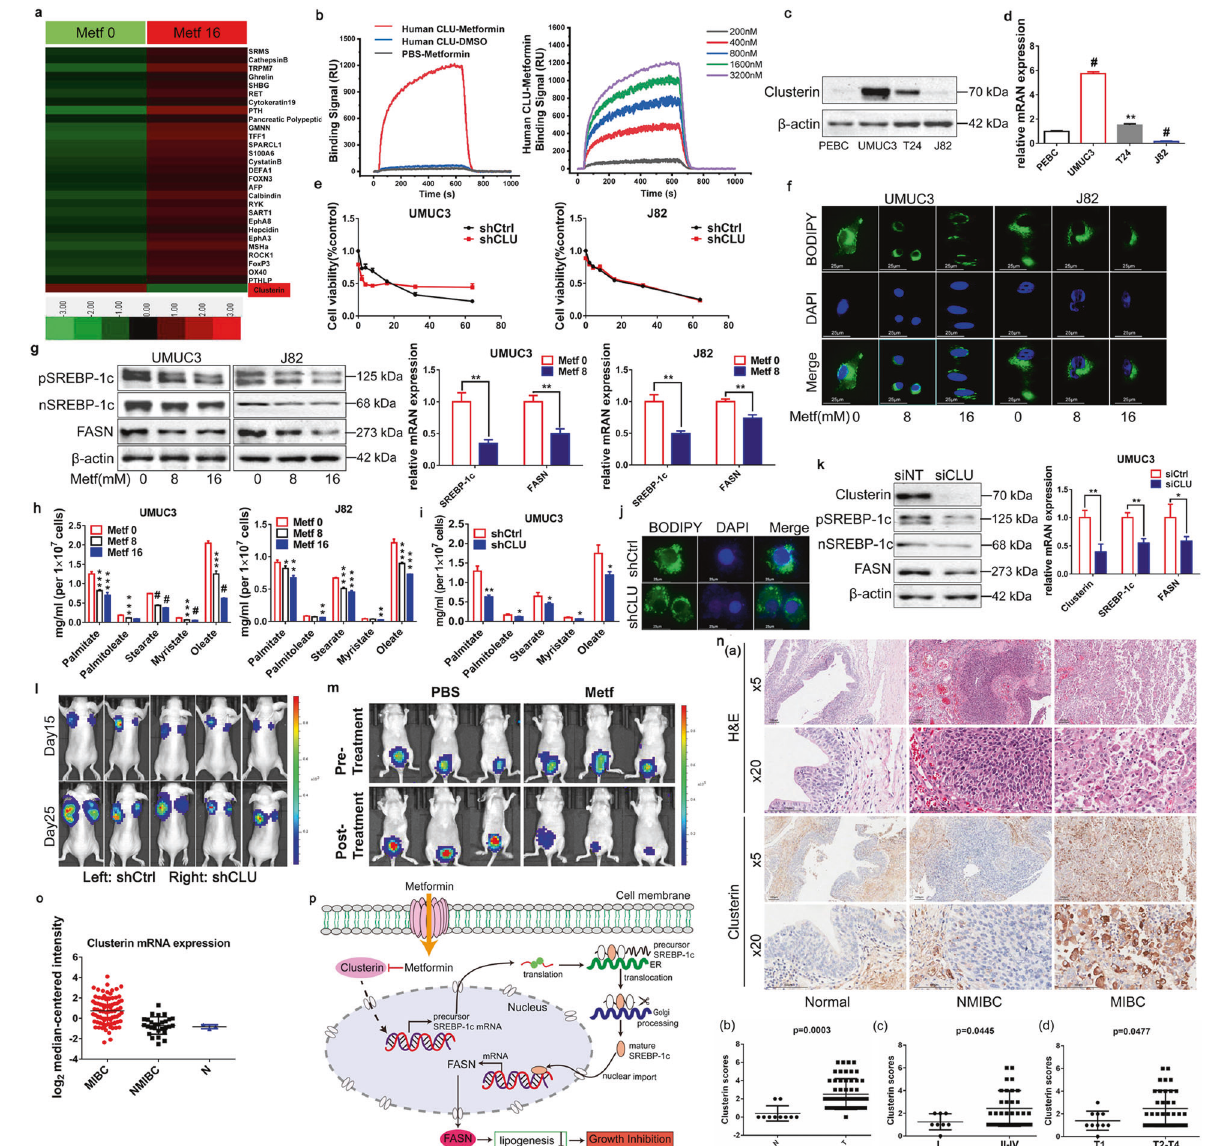
Fig. 1 a High-throughput protein chip was used to screen differential proteins with metformin treatment in T24 cells for 48 h. Metf 0 metformin 0 mM, Metf 16 metformin 16 mM. b SPRi binding signal curve of metformin to Clusterin protein. c Western blot analysis of Clusterin protein expression in three human bladder cancer cells and one normal bladder cell ( n = 3). d RT-PCR analysis of Clusterin mRNA expression in three human bladder cancer cells and one normal bladder cell ( n = 3). e MTT was used to assess the cell proliferation after Clusterin knockdown and the effect of metformin on inhibiting proliferation in Clusterin-knockdown cells compared with control cells ( n = 3). f Lipid droplet were visualized using BODIPY 493/503 after metformin treated in UMUC3 and J82 cells ( n = 3). g UMUC3 and J82 cells were treated with metformin for 36 h. Western blot was used to examine the protein expression of SREBP-1c precursor (pSREBP-1c), mature forms of SREBP- 1c (nSREBP-1c) and FASN. RT-PCR was used to examine the mRNA levels of SREBP-1c and FASN after treatment with metformin for 6 h ( n = 3). h UMUC3 and J82 cells were treated with metformin for 36 h. GC-MS analyzed the long-chain and short-chain fatty acids levels ( n = 3). i GC-MS determined the long-chain and short-chain fatty acids levels in Clusterin knockdown UMUC3 cells ( n = 3). j Lipid droplet were visualized using BODIPY 493/503 in Clusterin knockdown (shCLU) cells and control cells (shCtrl) ( n = 3). k Protein and mRNA expressions of Clusterin, SREBP-1c, and FASN were detected by Western blot, RT-PCR respectively in UMUC3 cells after siRNA silencing for 36 h. siNT = empty vector; siCLU = Clusterin silence ( n = 3). l The shCtrl and shCLU UMUC3 cells were injected subcutaneously into the left and right fl anks of the same nude mice, respectively. Tumor growth was monitored weekly using the IVIS Spectrum imaging system ( n = 5). m Images before and after treatment with metformin or PBS ( n = 5, each group). Tumor growth was monitored weekly using the IVIS Spectrum imaging system ( n = 5). n Tissue microarray analyzed Clusterin expression in total 66 tissue samples (10 normal tissues and 56 cancer tissues). N normal bladder, NMIBC non- muscular invasive bladder cancer, MIBC muscle-invasive bladder cancer, T bladder tumor. o Relative expression of Clusterin mRNA in bladder tumor tissues obtained from TCGA database. p A diagram summarizes that metformin inhibits Clusterin-mediated fatty acid synthesis pathway. ER endoplasmic reticulum. * p < 0.05, ** p < 0.01, *** p < 0.001, # p <